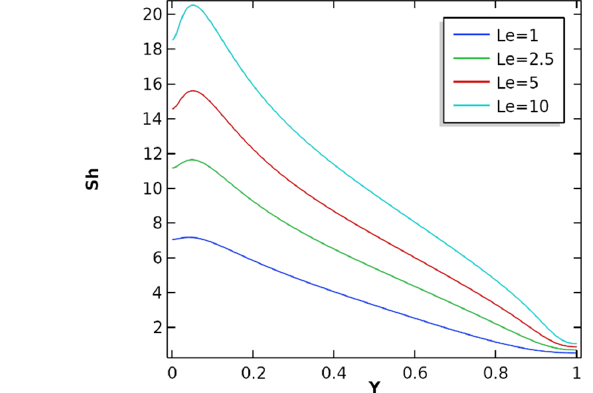
Figure 14. Variation in local Nu and Sh . Table 7. Average Nu and Sh